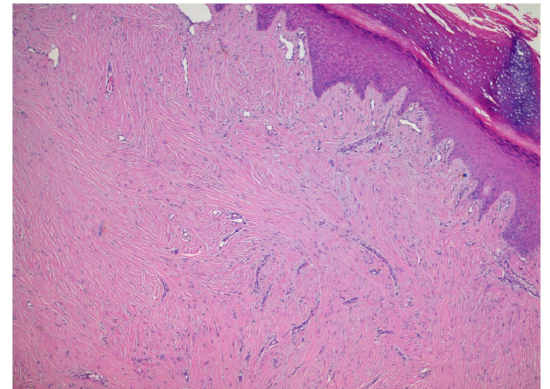
Figure 3. Proteus syndrome: Biopsy from the cerebriform nevus of the foot. Hematoxylin and eosin (magnification